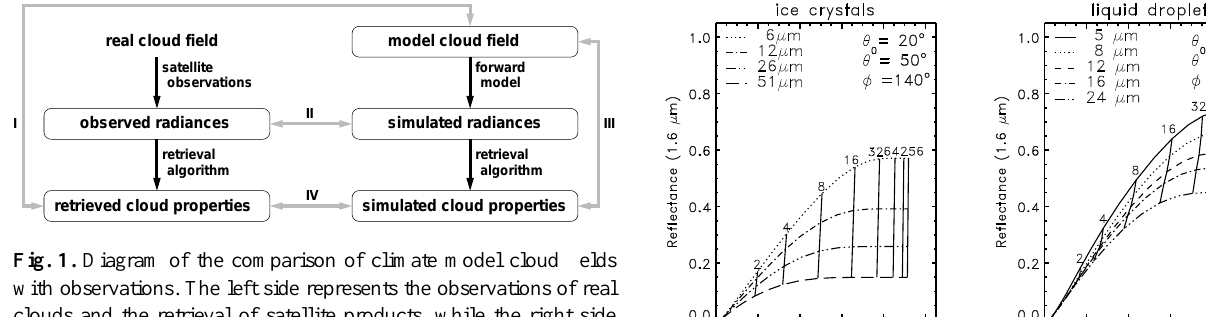
Fig. 1. Diagram of the comparison of climate model cloud fields with observations. The left side represents the observations of real clouds and the retrieval of satellite products, while the right side represents the model with simulated level 1 and level 2 satellite products. The boxes represent the available data sets, and the grey double-headed arrows represent routes along which comparisons can be performed between them. It should be noted that route III does not involve any reference to the real cloud field, but it is used to diagnose the climate model-forward model-retrieval chain.